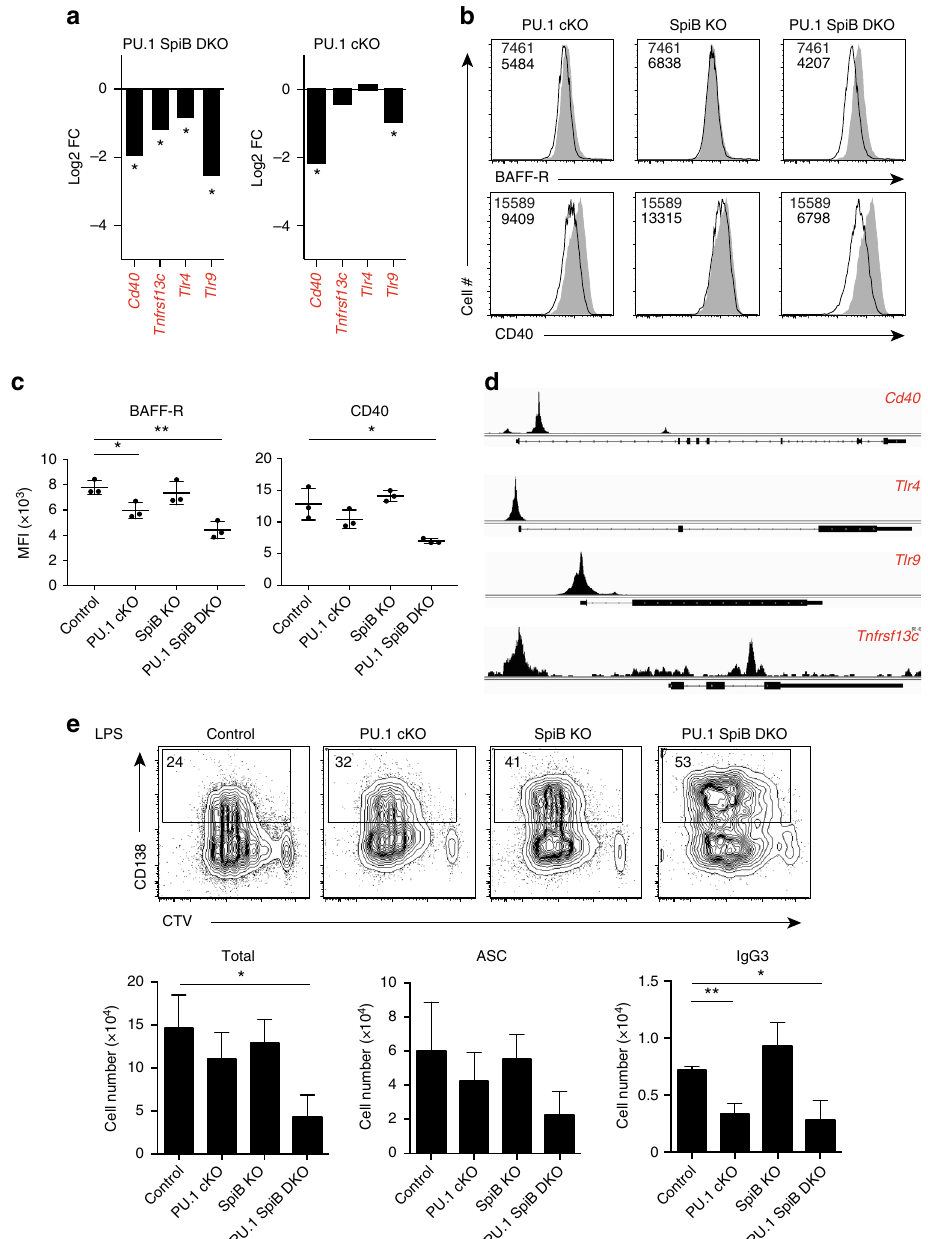
Fig. 7 PU.1 and SpiB are required to maintain the expression of several immune sensors. a Gene expression (from Fig. 5) for the indicated genotype is plotted as the mean fold change (log 2 , from 2 experiments) relative to the expression in the control genotype. *Indicates genes that are DE relative to controls (de fi ned as log 2 fold change > 0.6-fold, log 2 RPKM (reads per kilobase of exon model per million mapped reads) > 0, P < 0.15). b Flow cytometric analysis showing the expression of BAFF-R or CD40 on activated B cells of the indicated genotype (black line), relative to control B cells (solid gray), 48 h after stimulation with CD40 L + IL-4. c Mean fl uorescence intensity (MFI) is graphed as the mean ± s.d. Each circle represents the results from an individual mouse. P -values compare the indicated samples (two tailed t -test). * P < 0.05, ** P < 0.01. Data in b , c are from 3 experiments. d ChIPseq identi fi es proximal promoter-binding sites for PU.1 for the genes shown in a . Gene structures are shown below. Gene names in a , d with PU.1 peaks ( P < 10 − 6 ) are indicated in red. Data are representative of two experiments. e Impaired survival of PU.1 SpiB DKO B cells in response to the TLR4 agonist LPS. Resting lymph node B cells from mice of the indicated genotype were labeled with CTV and cultured in the presence of LPS for 4d before fl ow cytometric analysis. Numbers in the boxes are the proportion of CD138 + antibody-secreting cells (ASC). Data are representative of 3 experiments. Quantitation of the total cell number (left), total number of ASCs (middle) and IgG3 + cells (right) is shown in the lower graphs. Data are the mean ± s.d. for three independent experiments. P -values compare the indicated samples (two tailed t -test). * P < 0.05, ** P < 0.01. The full gating strategies are shown in Supplementary Fig. 9A and B,